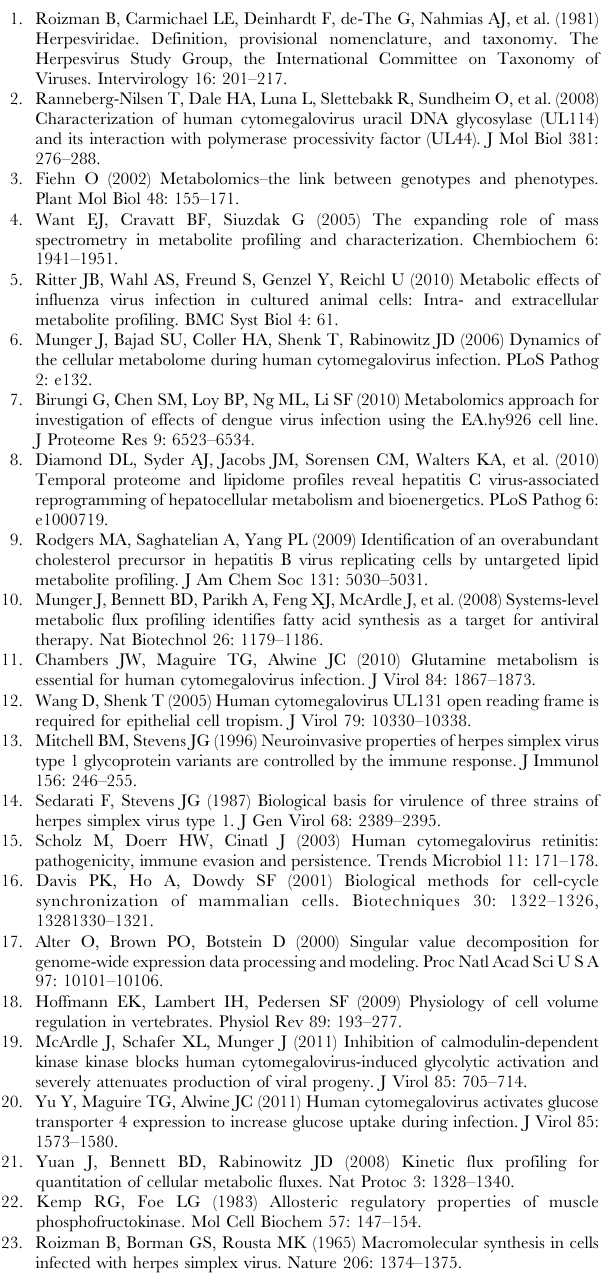
time course are indicated. Values are averages of duplicate independent biological